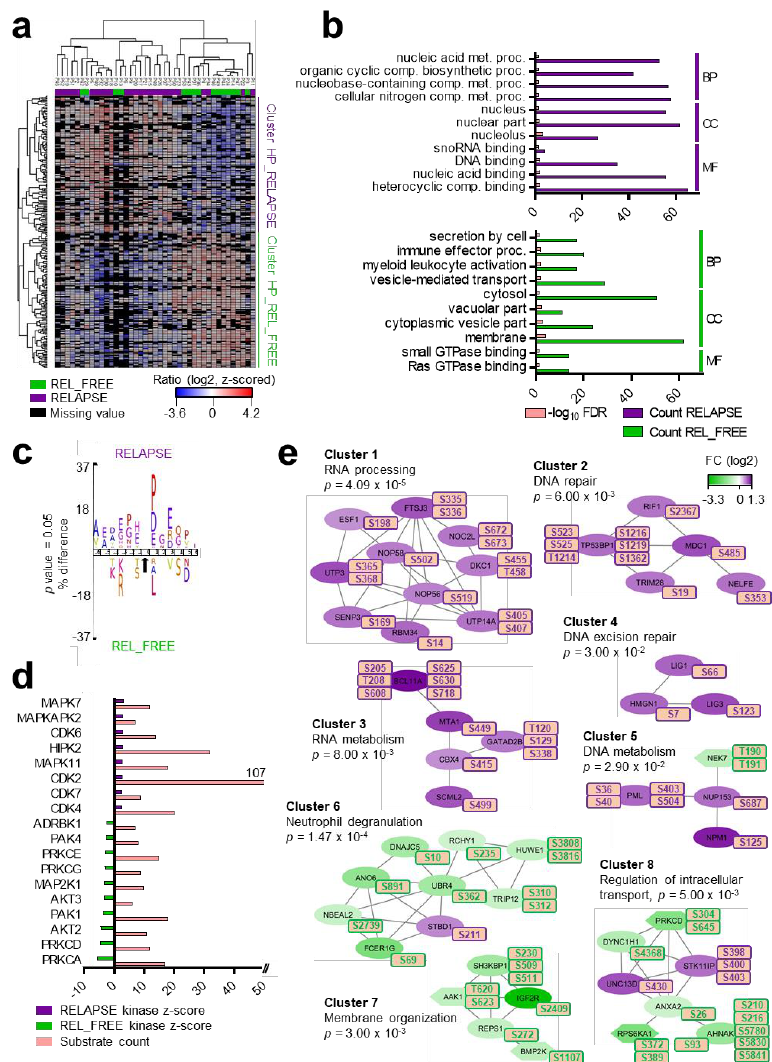
Figure 3. The AML RELAPSE phosphoproteome is enriched in cyclin-dependent kinase (CDK) substrates and RNA processing casein kinase 2 (CSK2) targets. ( a ) Hierarchical clustering of 274 differentially regulated phosphorylation sites revealed two clusters: HP (High Phosphorylation)_RELAPSE (in purple) and HP_REL_FREE (in green). The SILAC log 2 ratio scale and color code is also shown. ( b ) GO analyses of the two phosphoprotein clusters identified in Figure 3a were performed to reveal enriched BP, indicated to the right in the figure, CC and MF. The GO terms are listed in the left part of the figure; the upper part of the figure corresponds to the upper RELAPSE cluster identified in Figure 3a whereas the lower part of the figure corresponds to the lower REL_FREE cluster. The x-axis indicates the number of phosphoproteins/FDR. ( c ) Sequence motif analysis of the ± six amino acids, flanking the differentially regulated phosphorylation sites for either cluster. ( d ) Kinase-substrate enrichment analysis (KSEA) of differentially regulated and unregulated phosphorylation sites. The kinase z-score (X axis) is the normalized score for each kinase (Y axis), weighted by the number of identified substrates. ( e ) Networks of PPI based on STRING database and visualized in Cytoscape after ClusterONE analysis. Significance of networks of high cohesiveness is shown with the p value of a one-sided Mann–Whitney U test. The di ff erentially regulated phosphorylation site(s) is shown next to each protein. FC of phosphorylation are color-coded; purple-colored proteins showed a higher phosphorylation in the RELAPSE group and green-colored proteins showed a higher phosphorylation in the REL_FREE group. Kinases are specifically distinguished using hexagon